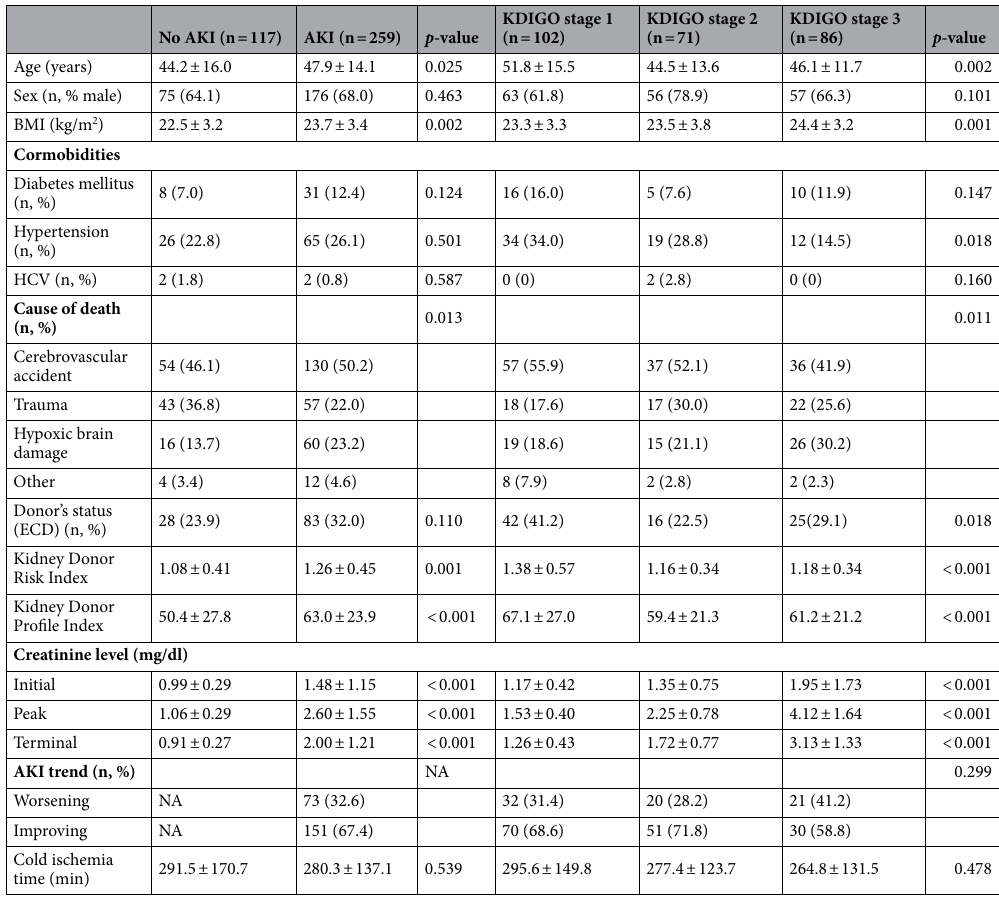
Table 1. Clinical characteristics of donors according to AKI stage. Continuous variables given as mean ± SD. AKI acute kidney injury, KDIGO kidney disease: improving global outcomes, BMI body mass index, HCV hepatitis c virus, ECD expanded criteria donor, NA not